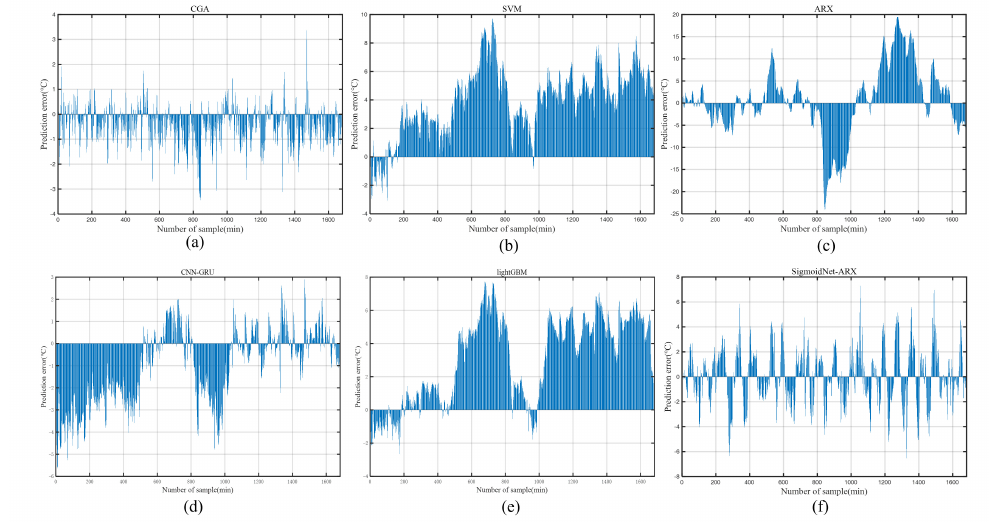
Figure 8. Prediction